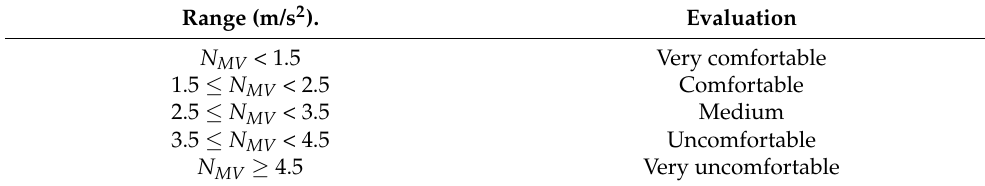
Table 3. Carriage vibration comfort index N MV evaluation grading range [15]. Range (m/s 2 ).